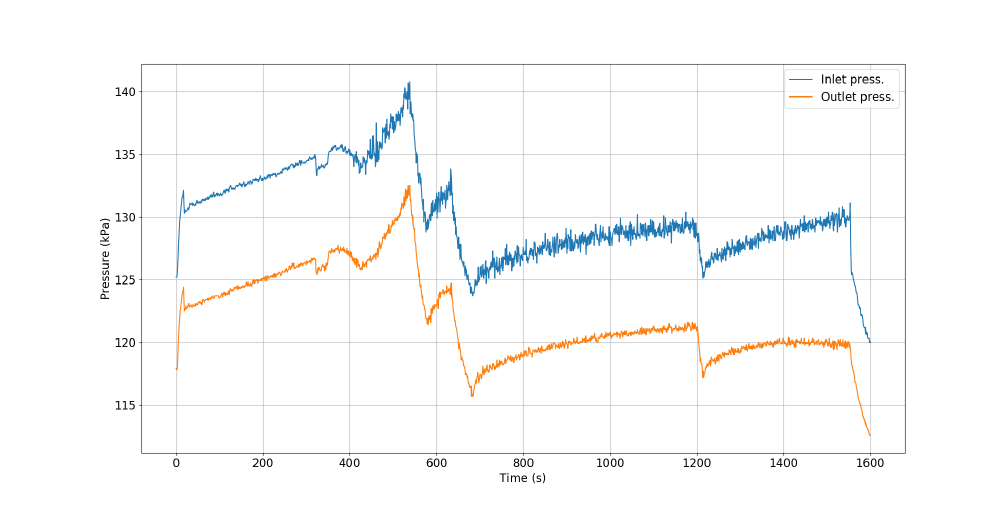
Figure 14. Pressures during 120 kPa and 400 kg/(m 2 . s)